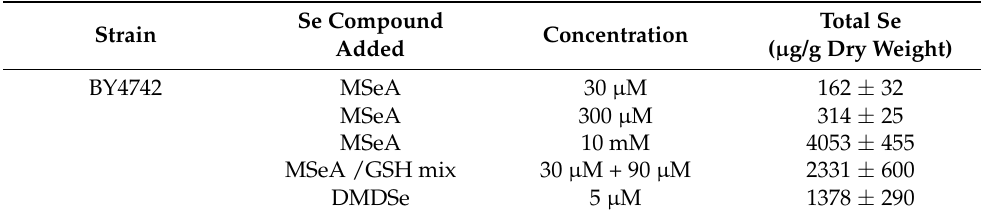
Table 3. Total Se content ( µ g/g dry weight) of BY4742 cells after 30 min incubation with MSeA, MSeA /GSH mix or DMDSe in SD medium. Means and standard deviations were calculated from three replicate measurements of at least two independent